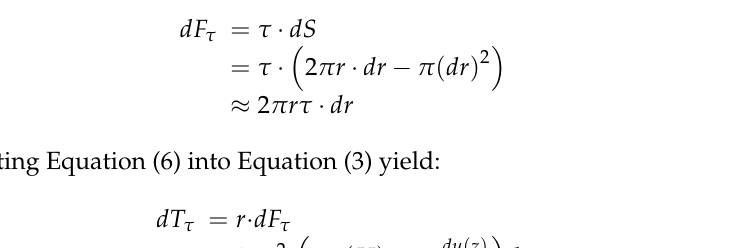
Figure 10. MRF shear force versus velocity distribution.